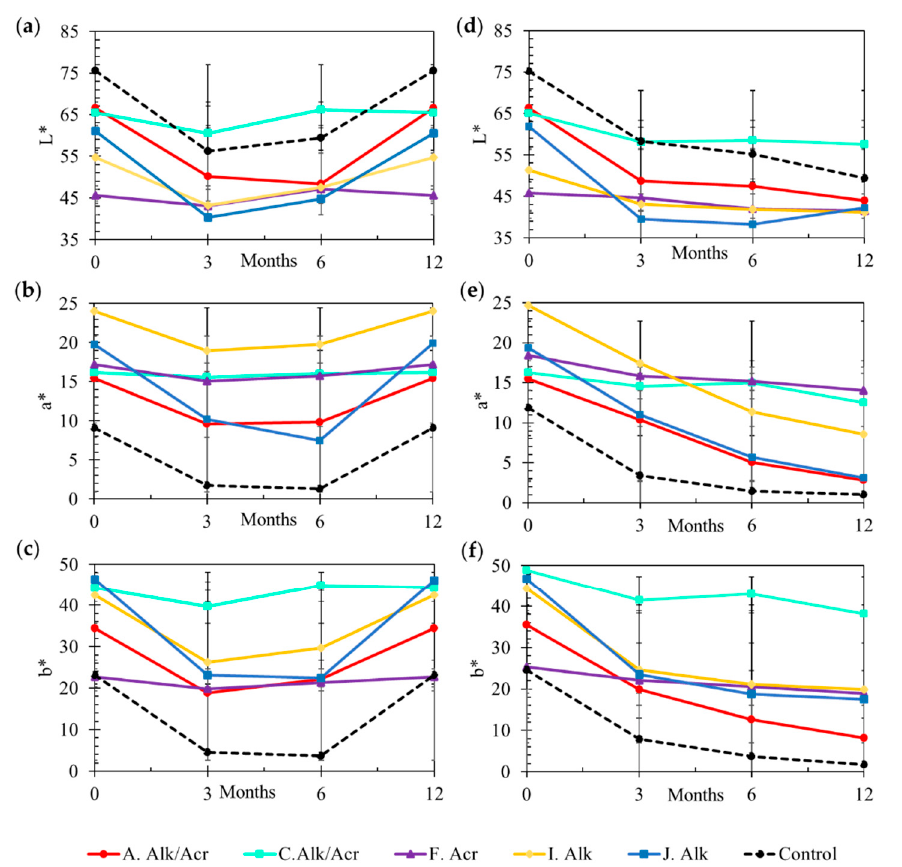
Figure 4. Describes CIELAB color parameters measured during 12 months of exposure. Graphs ( a ), ( b ), and ( c ) respectively display L* lightness, a* red to green, b* yellow to blue variations in Wisconsin, and ( d ), ( e ), ( f ) respectively: L* , a* , and b* variations in Mississippi. Error bars represent standard deviation at 95% of confidence interval.